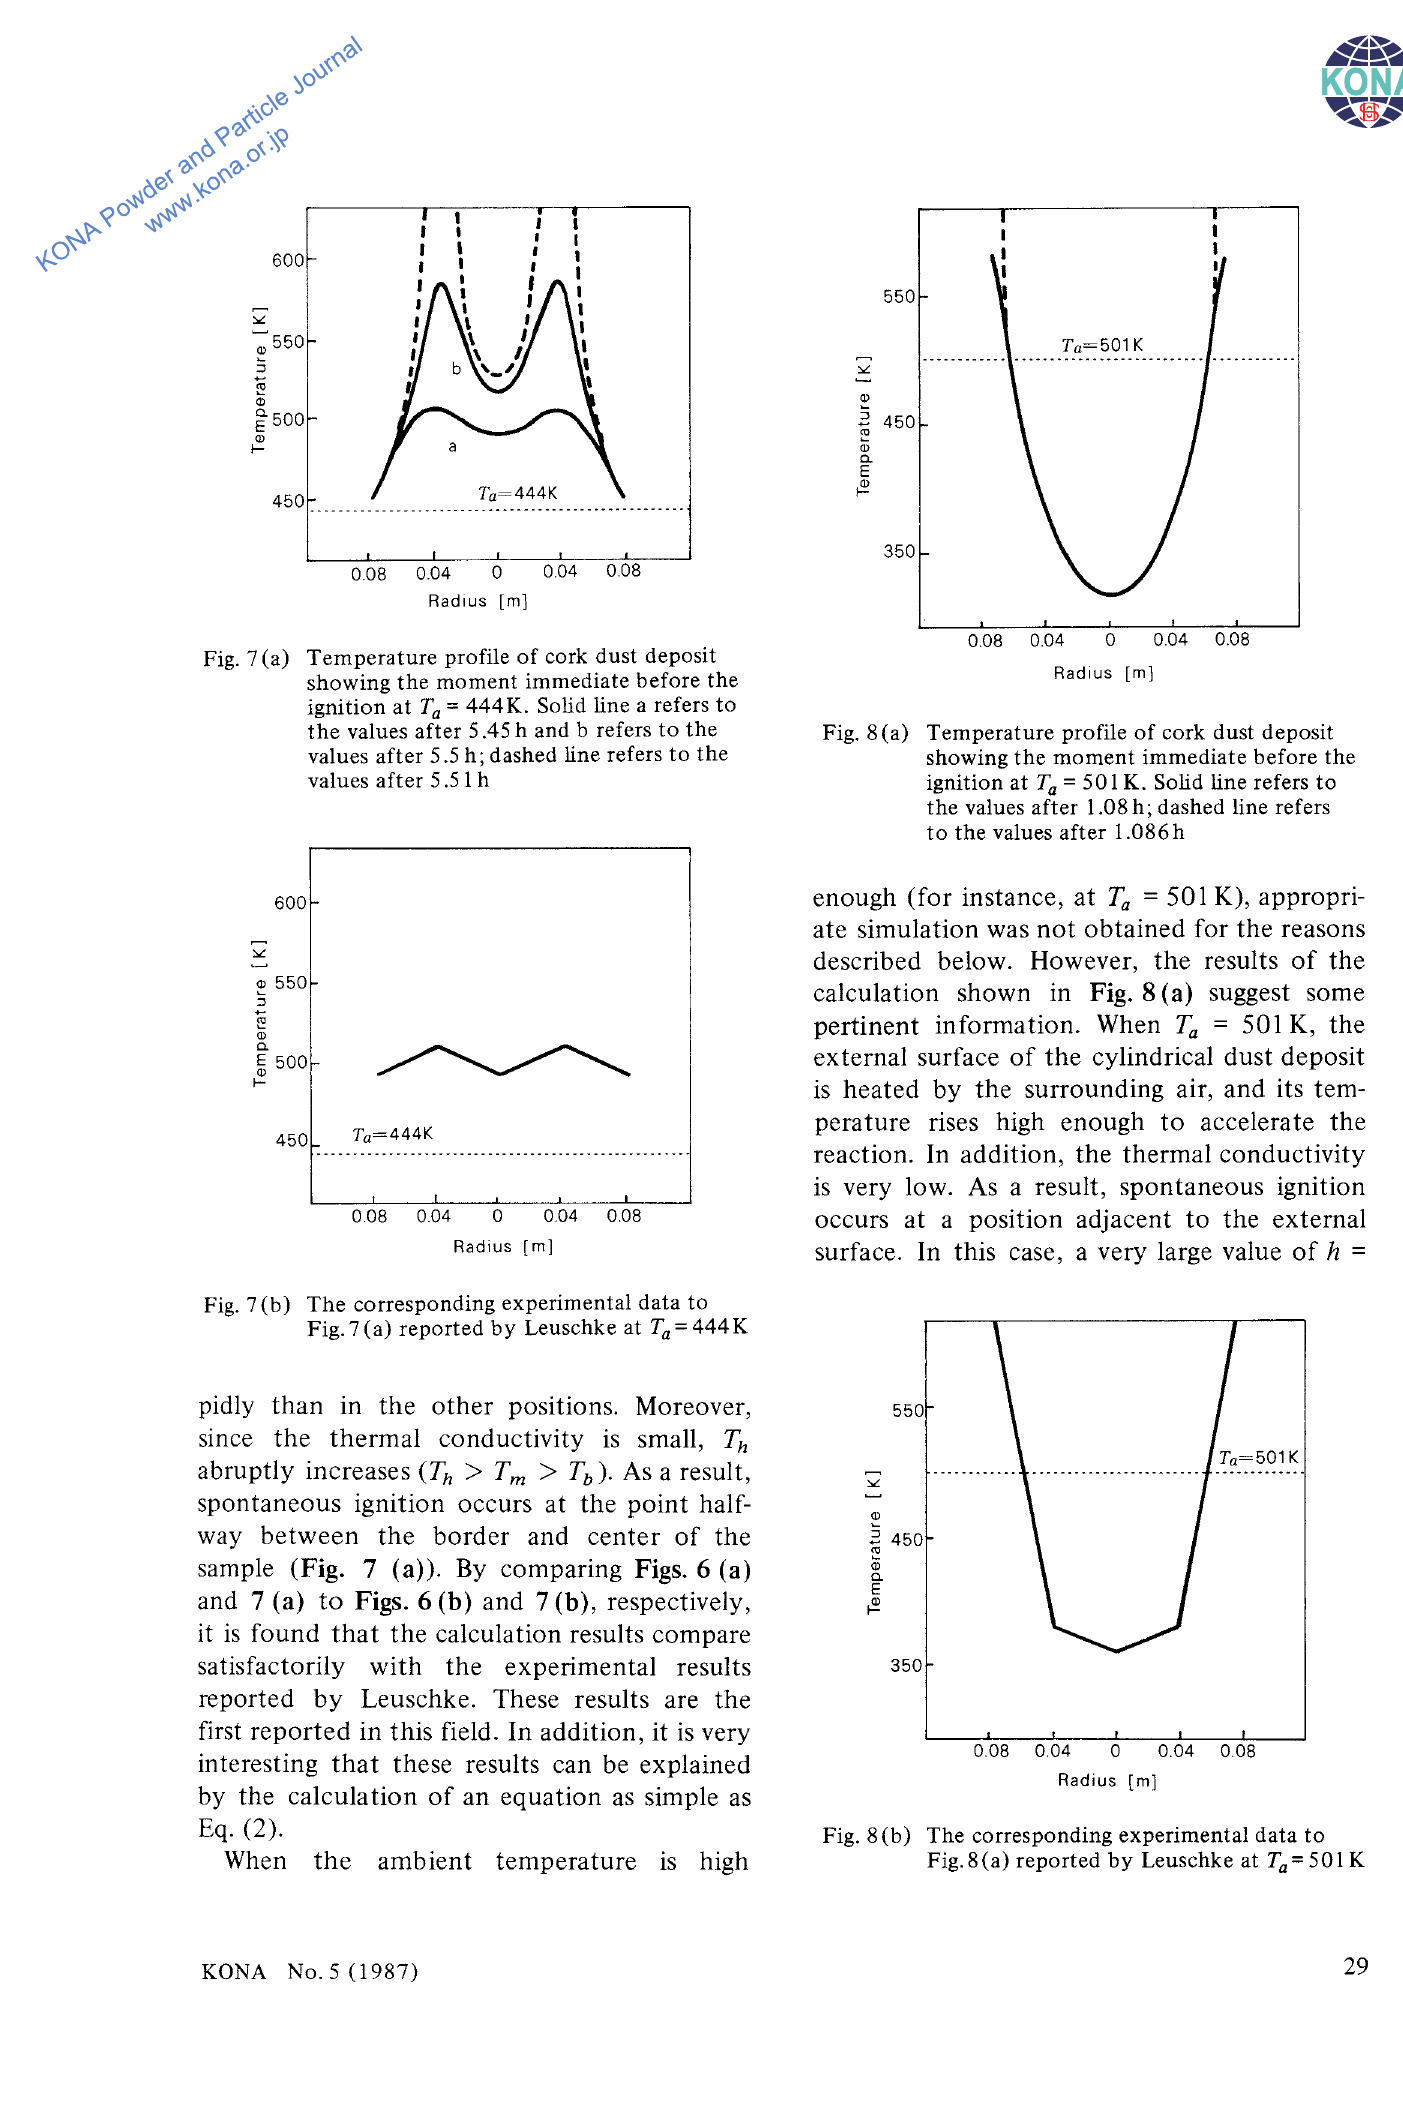
Fig. 8 (b) The corresponding experimental data to Fig. 8 (a) reported by Leuschke at Ta =50 1